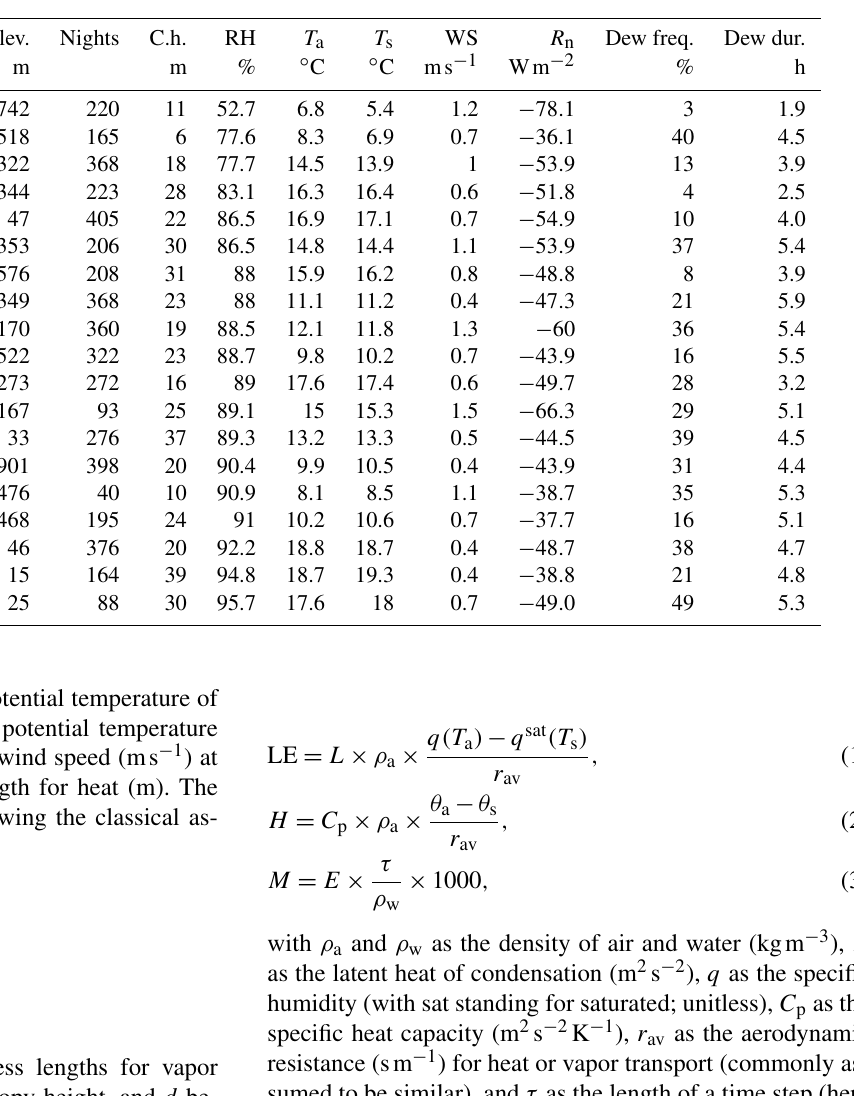
Table 2. Summary of the results for the forested sites ordered with an increasing RH. Dew frequency, duration and meteorological parameters (averaged from 23:00 to 05:00 the next day) have been calculated within canopy, except R n (above canopy). C.h. stands for canopy height, and elev. stands for